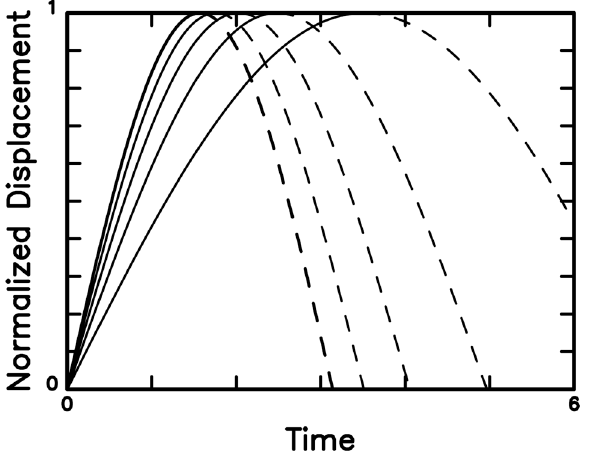
Figure 6. The slip of the slider for five values of h , i.e., 0.0, 0.2, 0.4, 0.6, 0.8 N/(m/s) (upside down), when K = 10 N/m, m = 10 kg, and c = 1